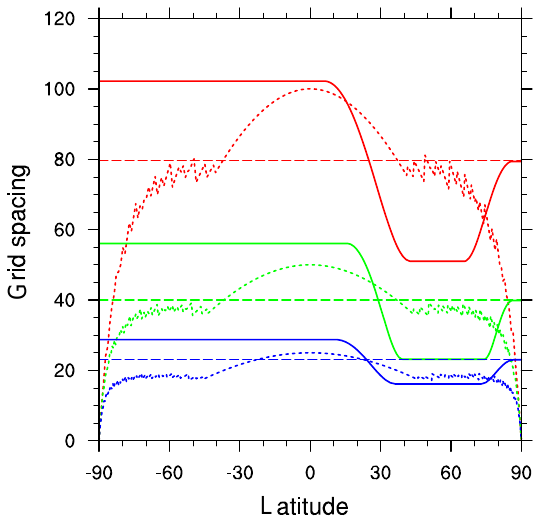
Figure 2. Latitude grid spacing (solid lines) of 400 × 250 (red), 800 × 500 (green) and 1600 × 865 (blue) variable-resolution latitude–longitude grids. Dotted lines indicate longitude grid spac- ing of the corresponding reduced grids. Dashed lines show latitude grid spacing in the constant-resolution grids with the same number of